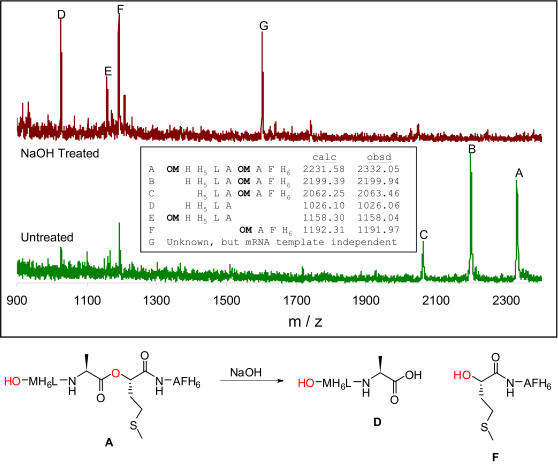
Ester hydrolysis shows that α-hydroxy methionine is incorporated.Top–Comparison of the peptide masses before and after treatment with NaOH which shows the expected hydrolyzed products labeled D, E and F. Bottom—Expected products from the hydrolysis of peptide containing an α-hydroxy methionine residue.